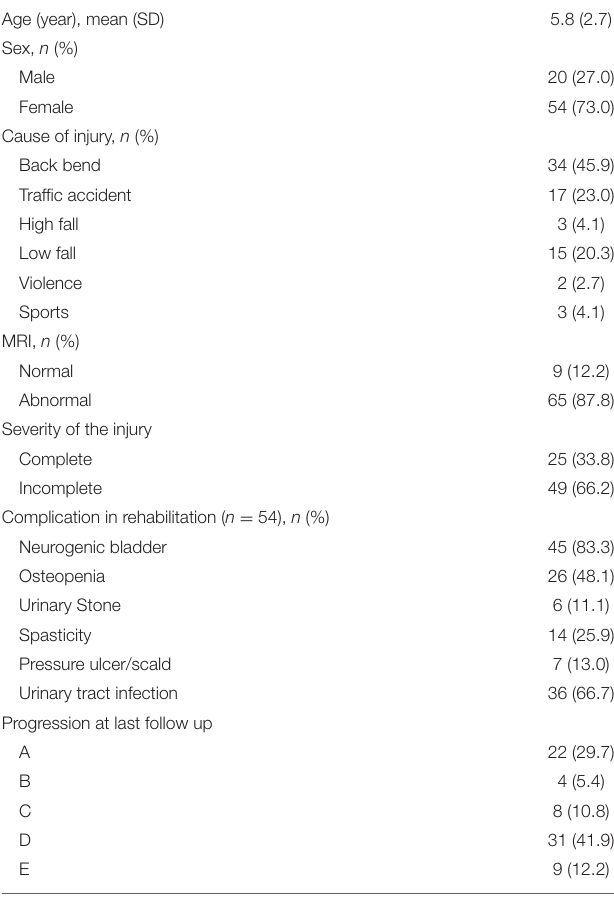
TABLE 1 | Clinical characteristics ( n =